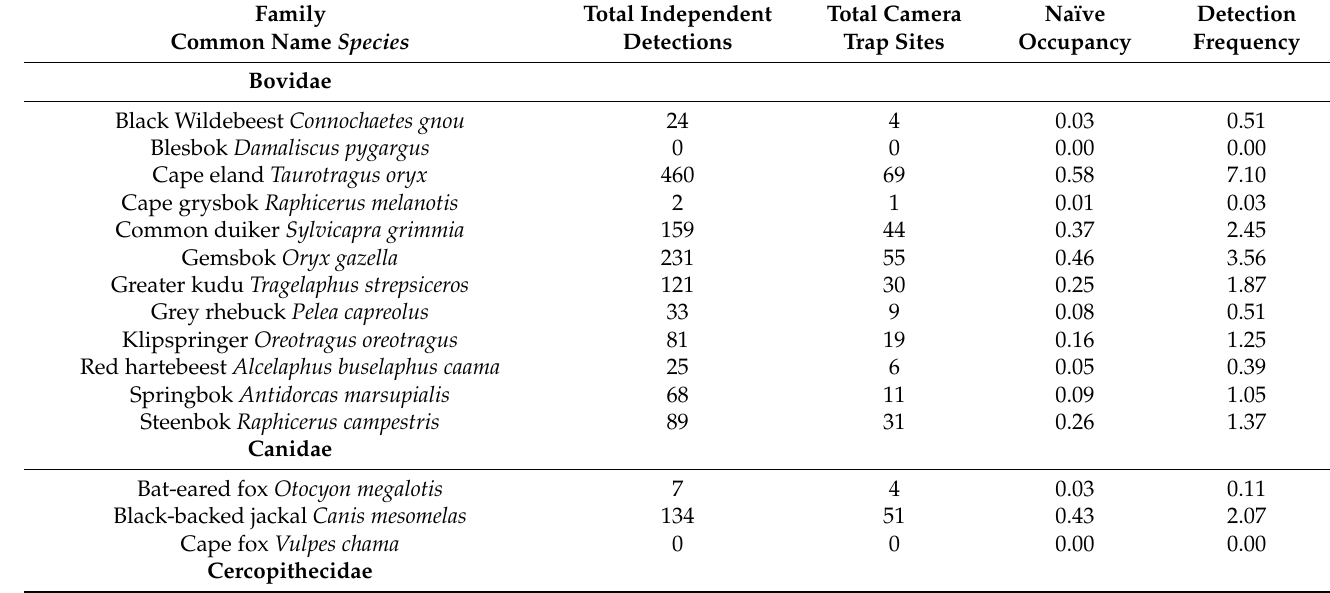
Table A4. General results of the camera trapping surveys conducted on the private protected area, presented per family and species. Shaded in light grey, the species/families that are absent or were not detected. Shaded in blue, the species/families that are true (i.e., known) absences. Total independent detections indicate the sum of independent detections, and the naïve occupancy is the proportion of camera trap sites at which the species was detected. The detection frequency (or relative abundance index [RAI]) is the camera trapping